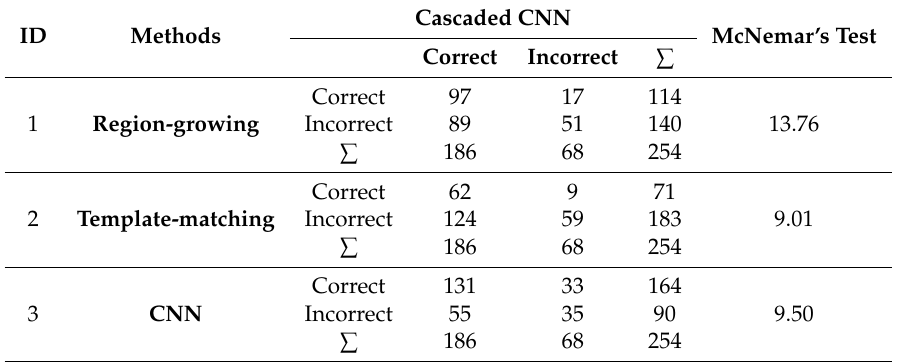
Table 6. The results of McNemar’s test in Test Area 2.